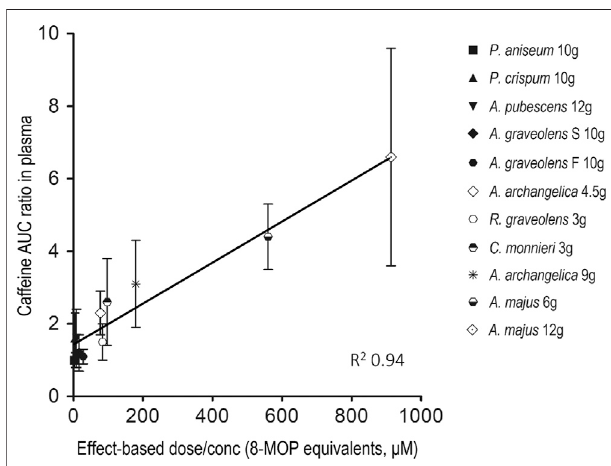
FIGURE 4 | Correlation between the area-under-the-concentration- time-curve (AUC) ratio of caffeine and the effect-based dose measure of the furanocoumarin mixture in ARFP extract. The data represent mean ± SD of caffeine AUC ratio with different effect-based dose measures in the ARFP extracts.